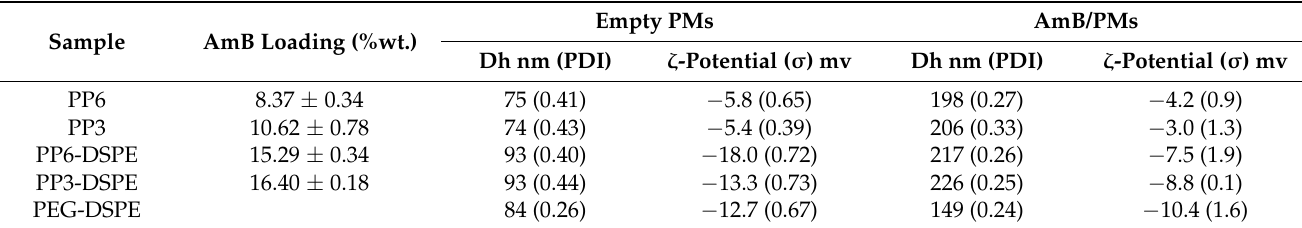
Table 2. Characterisation of micellar formulations. Drug content, hydrodynamic diameter (Dh) and ζ -potential values of empty and AmB-loaded nanoparticles measured at pH 7.0. Sample AmB Loading